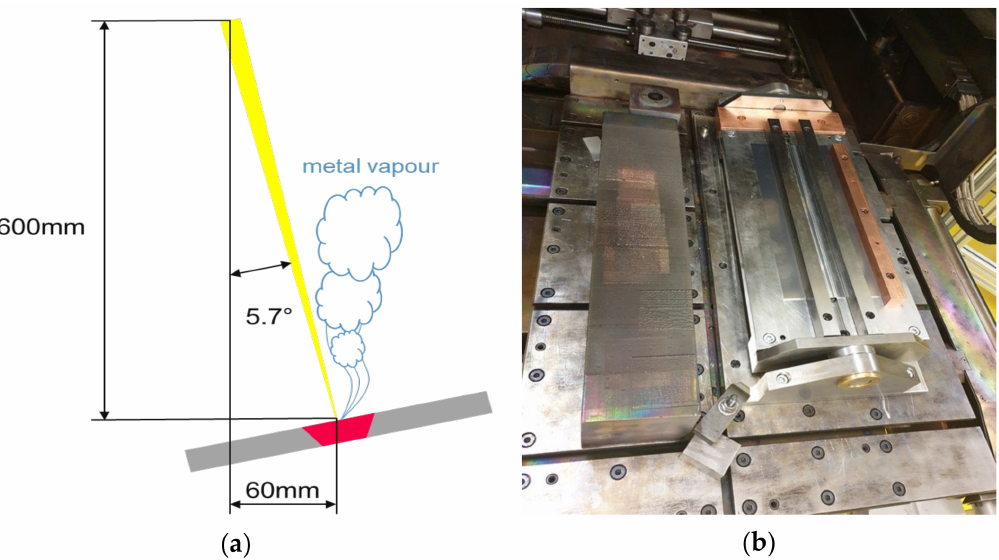
Figure 3. ( a ) Schematic of the tilted beam; ( b ) Pivoting clamping device with welded